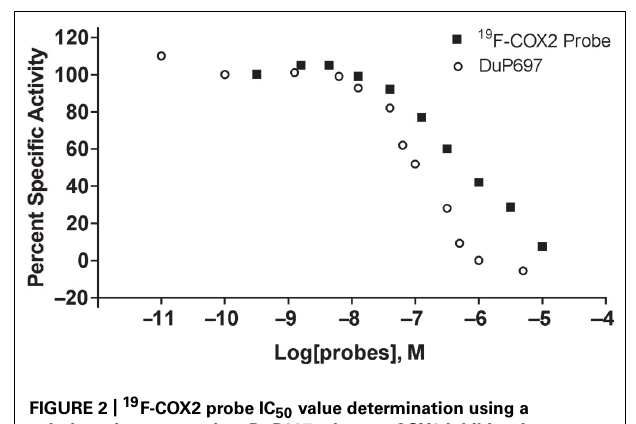
FIGURE 2 | 19 F-COX2 probe IC 50 value determination using a colorimetric assay against DuP697, a known COX2 inhibitor in a 96-well plate format. Data represent two independent